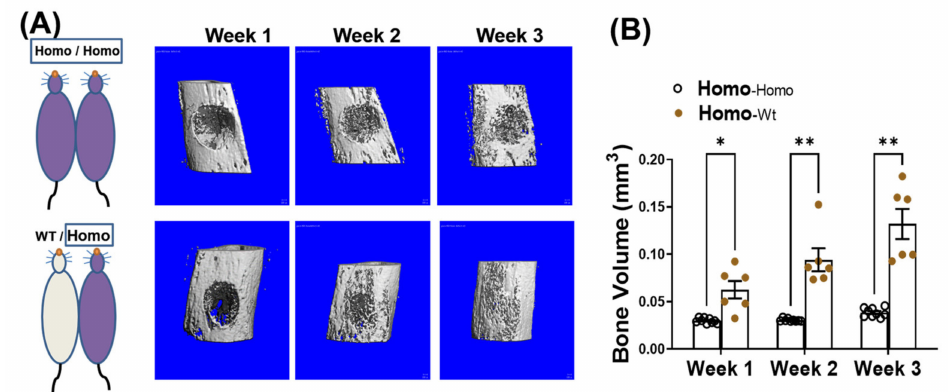
Figure 3. Pairing with WT mice improves bone healing in dKO-homo mice. ( A ): Representative 3-D reconstructed images of bone defects in proximal tibia. First row, bone defect areas of dKO-homo mice in homo/homo isochronic control pairings; second row, bone defect areas of dKO-homo mice in homo/WT heterochronic parings. ( B ) Quantification of bony-in-growth within defect areas. Data were expressed as Mean ± SEM; * p < 0.05, ** p < 0.01.